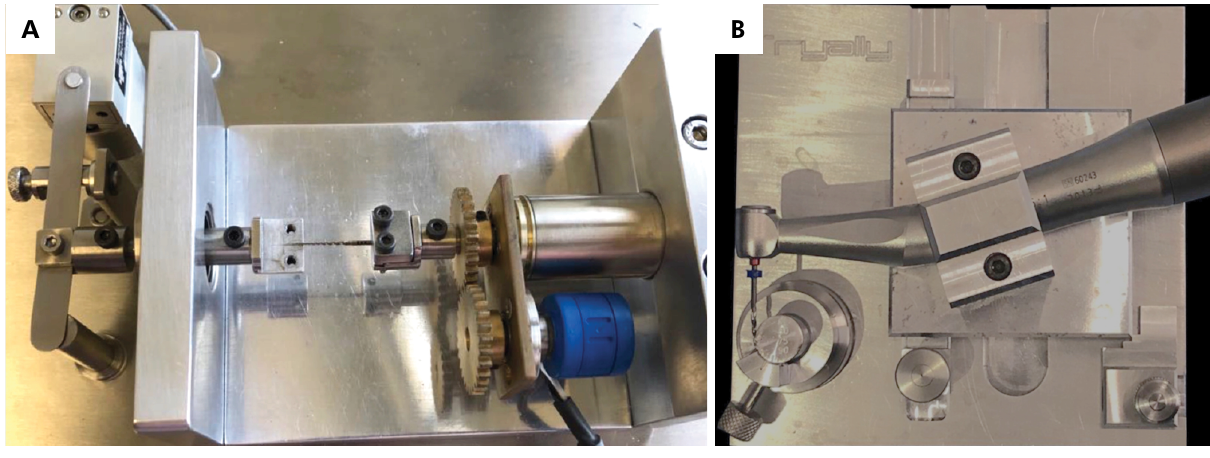
Figure 2. Experimental setup showing the (A) torsional fatigue test device and (B) cyclic fatigue test